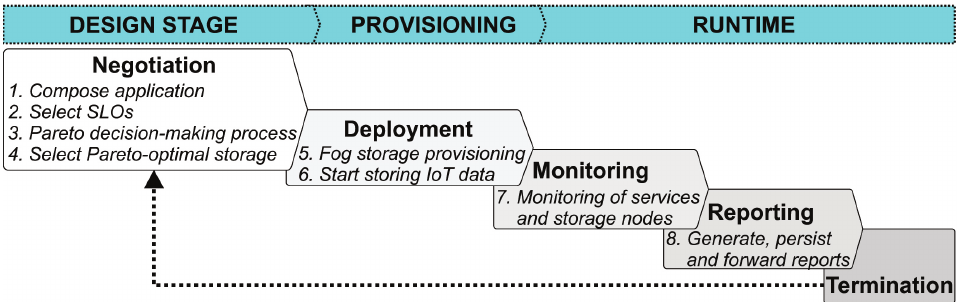
Figure 2. Modelling and implementing the SLA life cycle for Fog